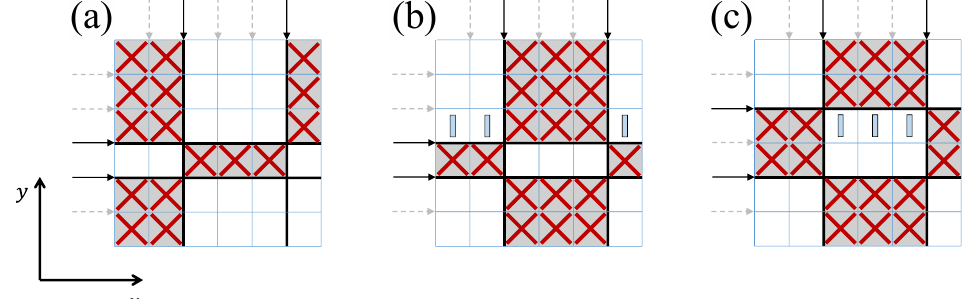
Figure 11: Compatible layers: z blocks, indicated by a red cross, cf. Fig. 6, are bound to alternating regions between a subset of horizontal and vertical grid lines, indicated by solid black lines. The empty blocks in the complimentary regions are free to choose between x and y . The horizontal and vertical lines are each selected from a set of { L − 1 } possible grid lines. The chosen (unchosen) lines are indicated by solid black (dashed gray) arrows. (a) and (b) depict the two possible colorings for the same selection of vertical and horizontal lines. If there are f free blocks in coloring (a), then there are L 2 − f free blocks in coloring (b). (c) Row swapping with respect to the layer at (b). Every block in the z direction was replaced with a block in the y direction and vice versa. y blocks are indicated by elongated rectangles in the y direction. The swapping changes the selection status of the horizontal lines bounding the line; from a solid arrow indicating a selected line to a dashed arrow indicating an unchosen line, and vice